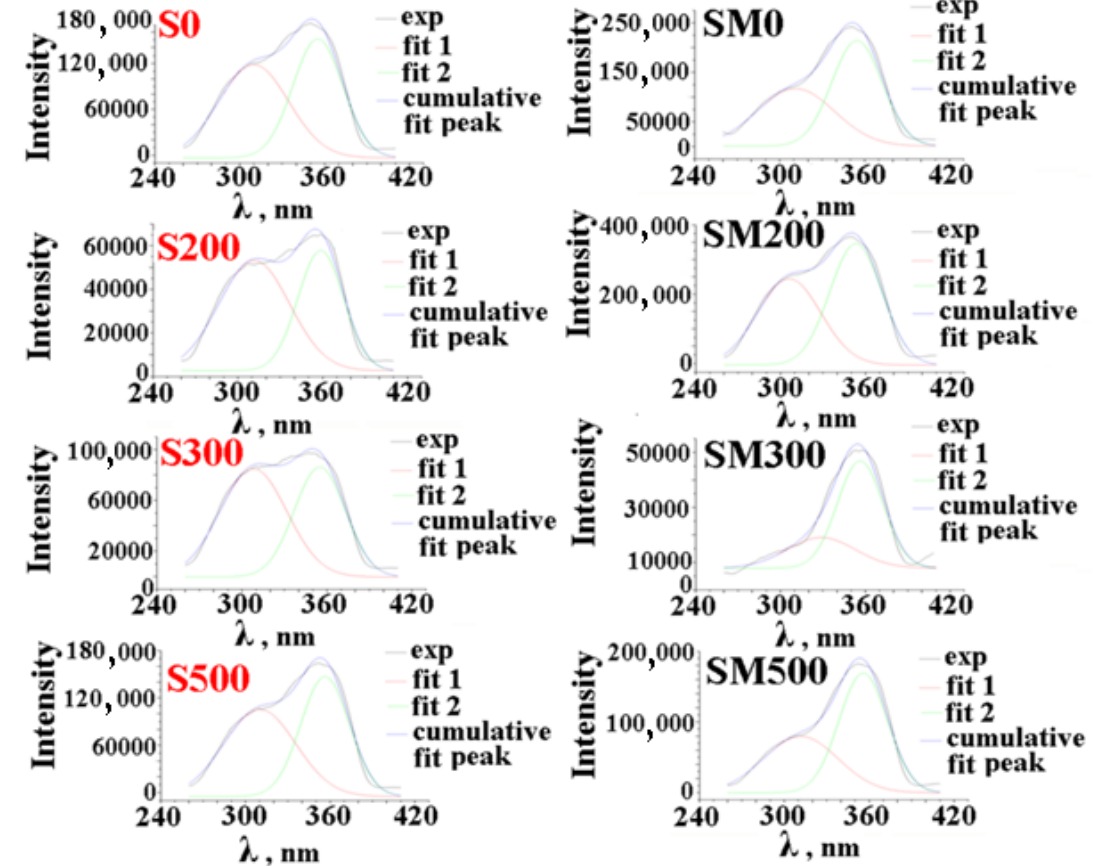
Figure 7. PL spectra NP and commercial powder CeF 3 before and after annealing in air at 200, 300 and 500